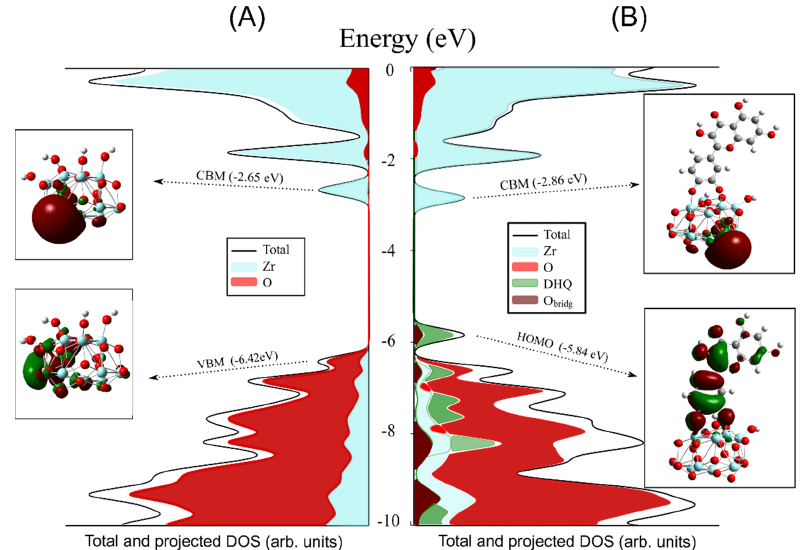
Figure 5. Total and projected density of states (DOS/PDOS), with FMO distributions of ( A ) [Zr 11 O 20 (OH) 4 ] and ( B ) [Zr 11 O 20 (OH) 2 ]/DHQ clusters, as calculated at CAM-B3LYP/6- 31G(d,p)/SDD(28) level. Gray: carbon, white: hydrogen, red: oxygen, and pale blue: zirconium atoms. The theoretical spectra of the [Zr 11 O 20 (OH) 2 ]/DHQ cluster and its constituents (free